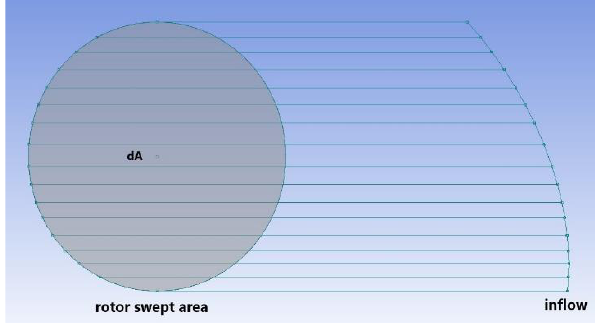
Figure 18. Schematic of the smaller area method